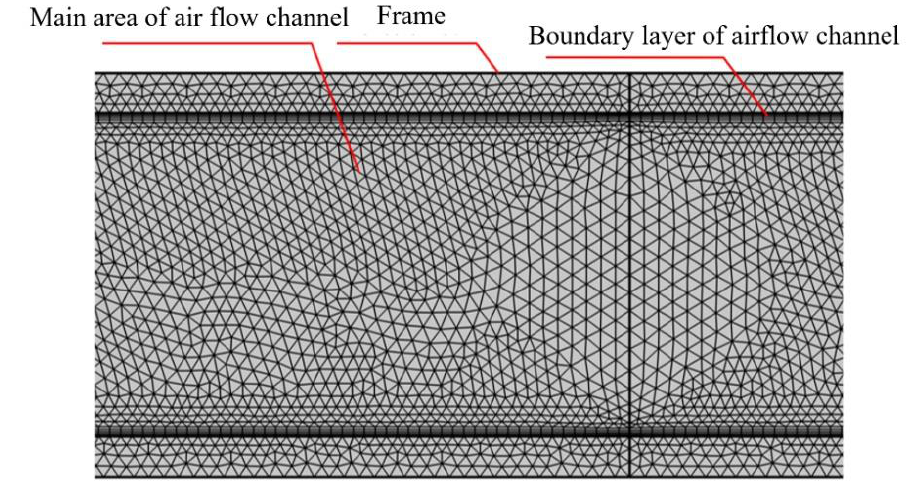
Figure 4. Schematic diagram of the single channel analog meshing.